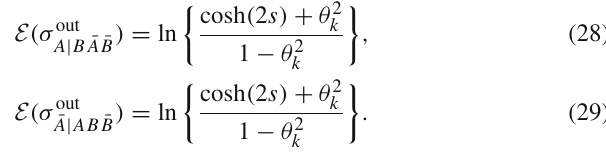
) between the mode A and the mode ¯ A as functions of the expansion rate σ and the momentum k for the Fig. 2 a Quantum entanglement E (σ out A ¯ A ) as functions of the mass m and the expansion volume (cid:9) for the fixed values of fixed values of m = (cid:9) = s = 1. b Quantum entanglement E (σ out A ¯ A k = σ = s = 1 Figure3c and f show how the mass m influences the 1 → 3 entanglement. From Fig.3c, we find that quantum entangle- ) first increases from the initial entanglement ment E (σ out A | B ¯ A ¯ B to the maximum and then reduces to the initial entangle- ment. From Fig.3f, we can see that quantum entanglement ) increases from zero to the maximum and then E (σ out ¯ A | AB ¯ B reduces to zero. This implies that, for the bosons with the larger mass m , the effect of the expansion of the universe on the 1 → 3 entanglement is not